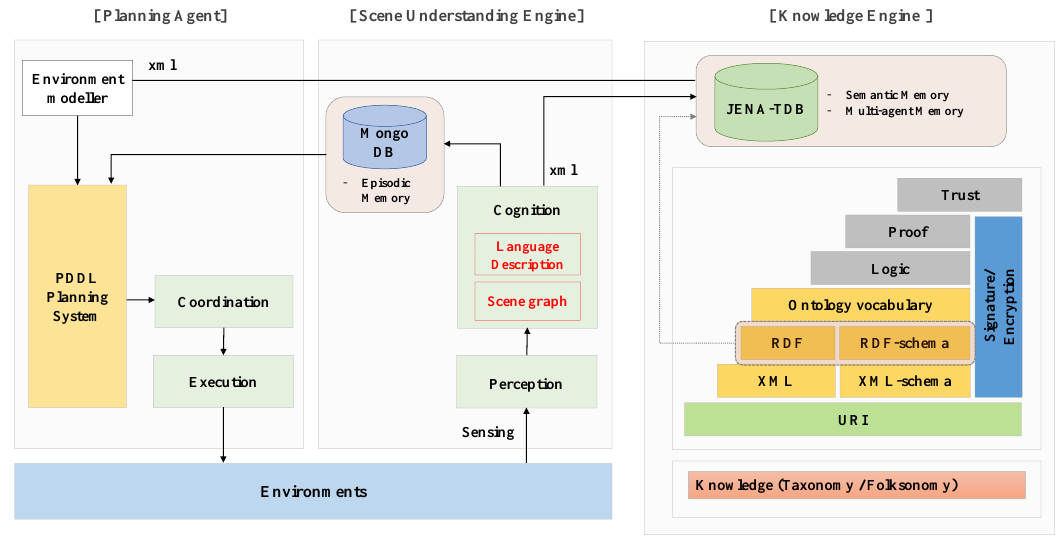
Figure 2. General overview of the proposed architecture.